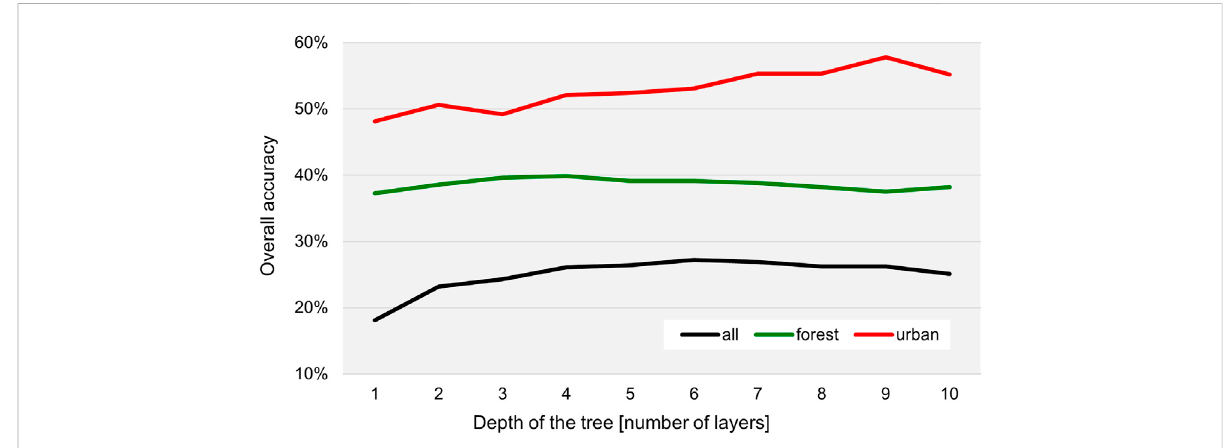
FIGURE 13 Overallaccuraciesoftheclassi fi cationtreesforallteninputclasses(black),threeforestclasses(green)andthreeurbanclasses(red)withrespect to the number of layers of the constructed decision